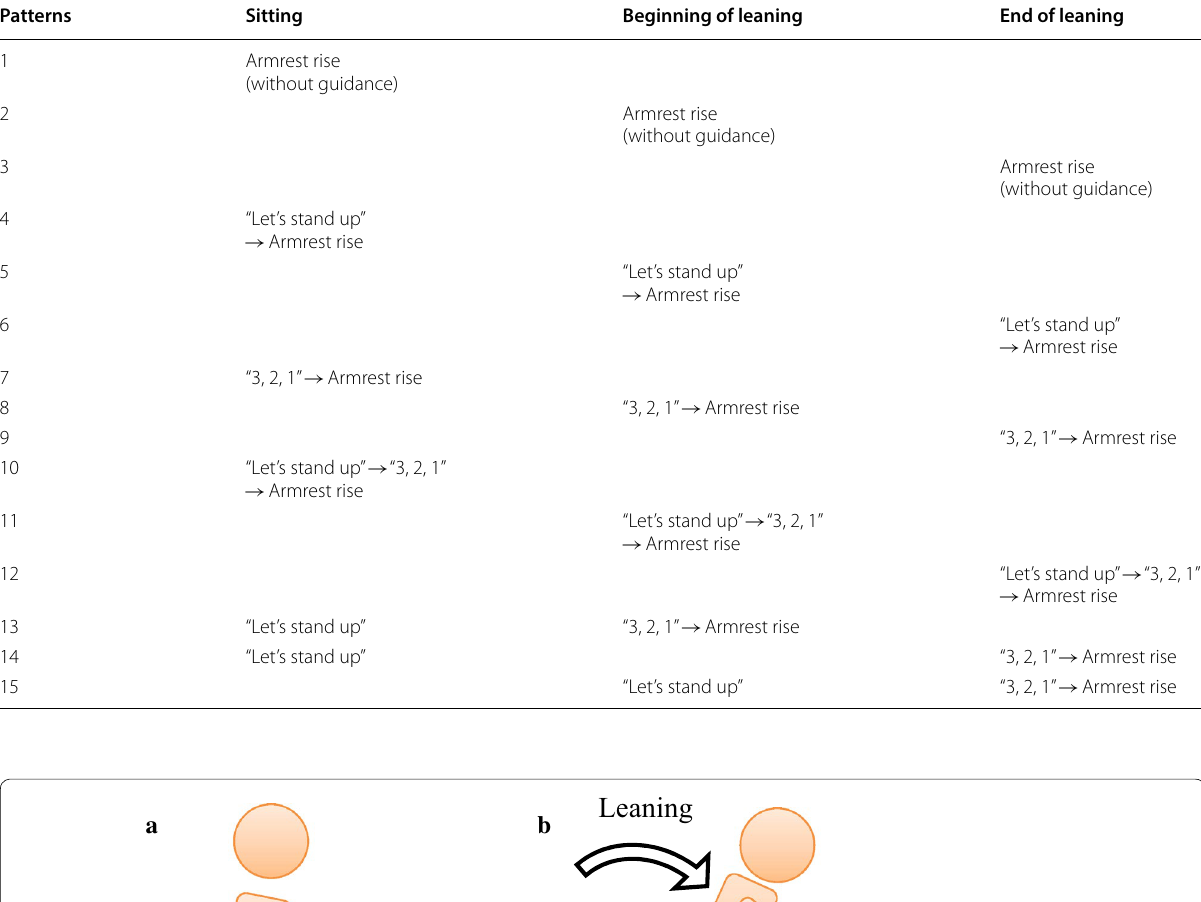
Table 1 Guidance and support patterns